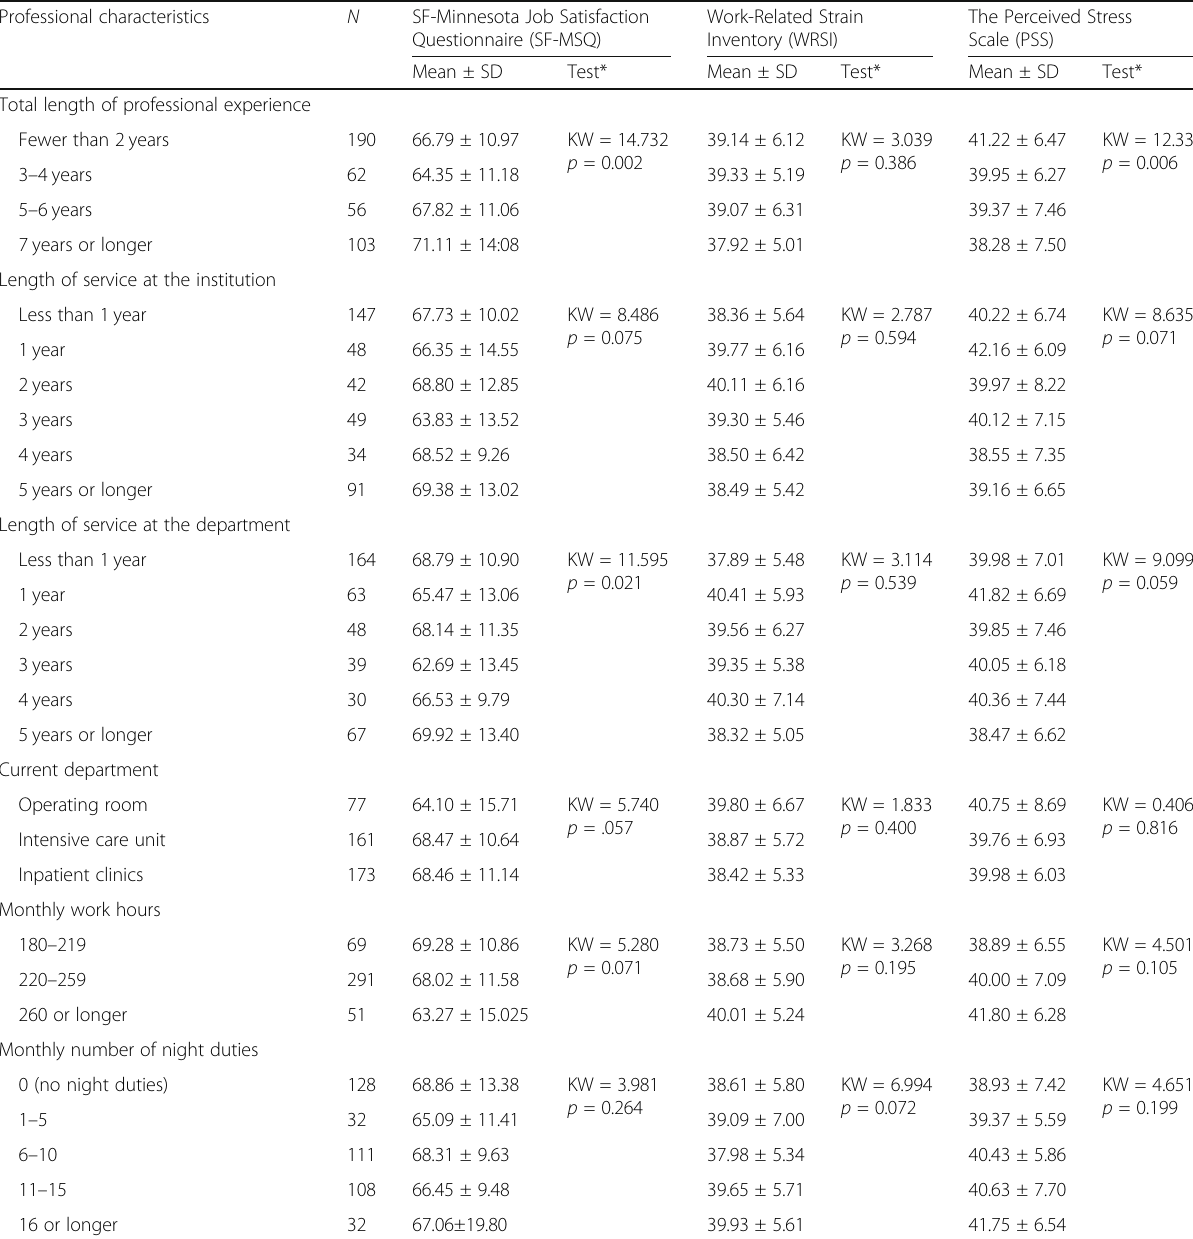
Table 6 Mean scores of SF-MSQ, WRSI, and PSS by the professional characteristics of nurses ( N = 411) Professional